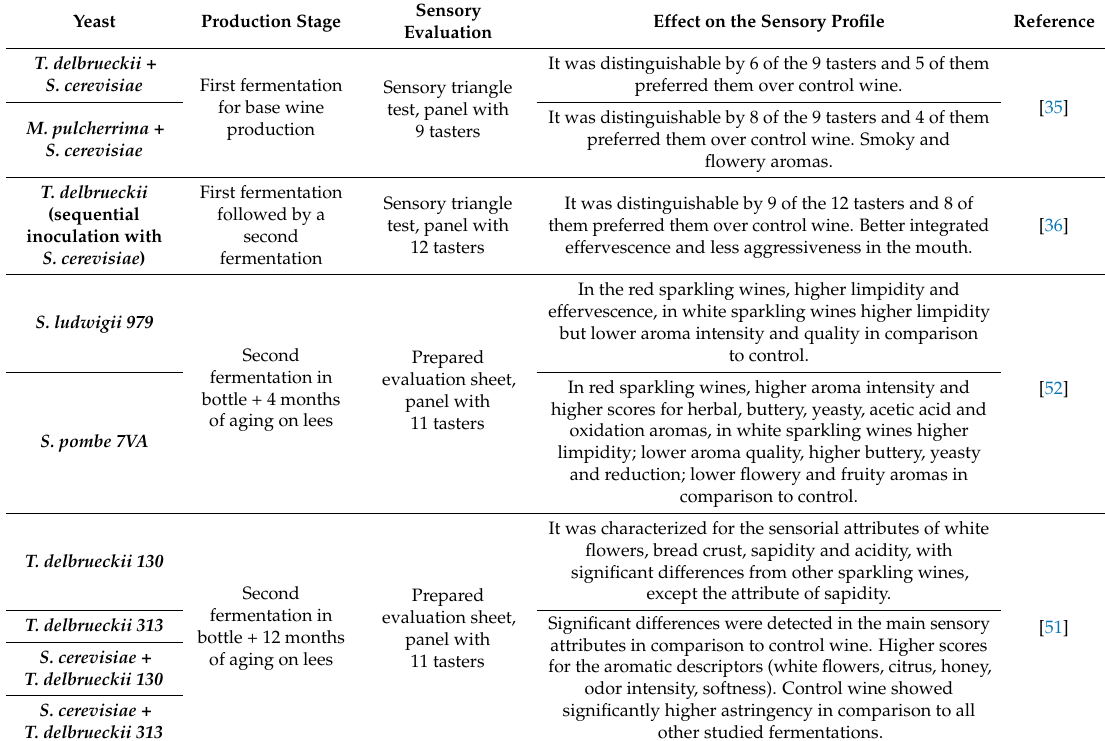
Table 3. Summary of the impact of non- Saccharomyces yeasts on sensory profiles of base wines and sparkling